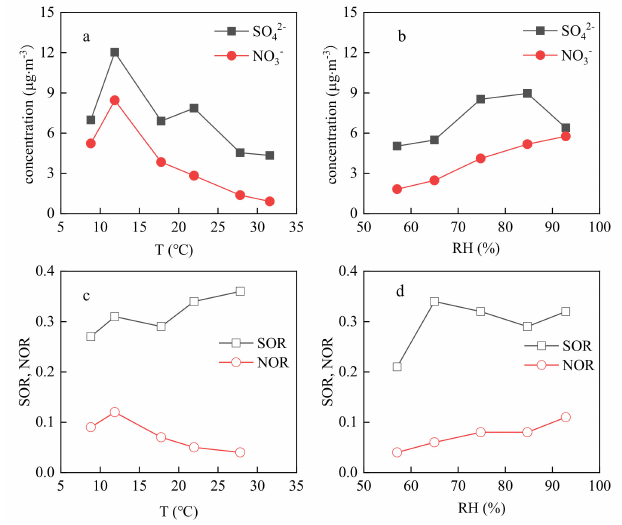
Figure 4. Evolution characteristics of SO4 2 − and NO 3 − ( a , b ) and their conversion rates (SOR and